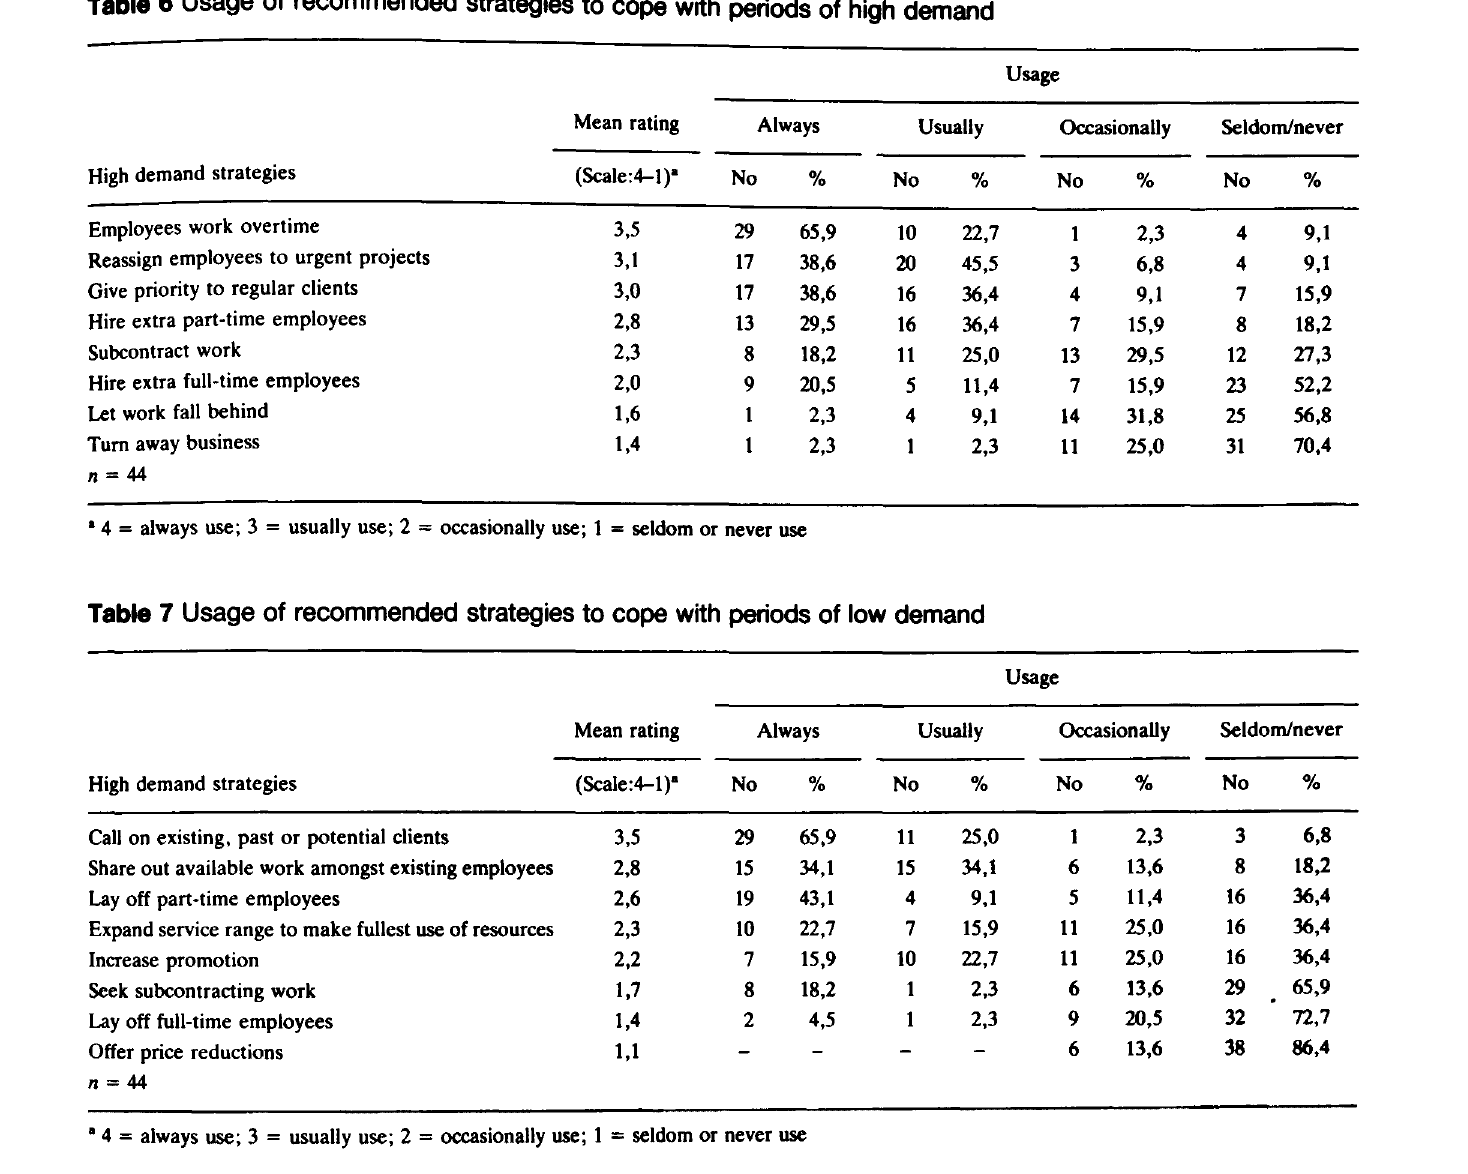
Usage Mean rating Always Usually Occasionally